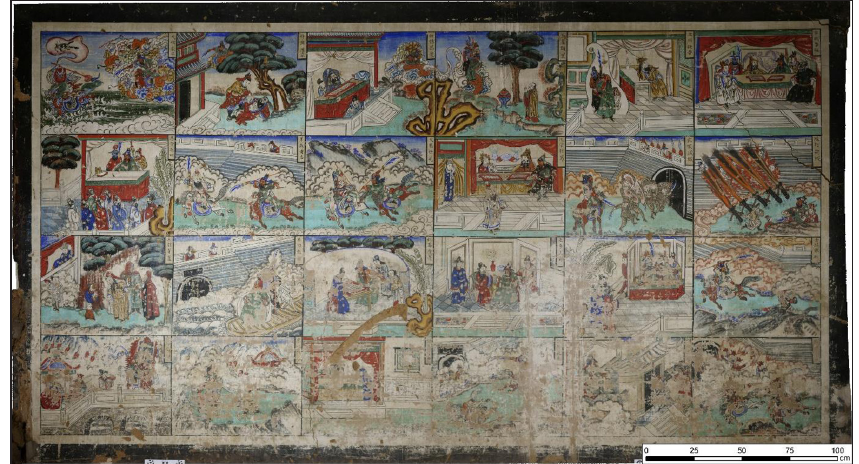
Figure 3: Room1 Wall 1 in Guandi Temple in Shangshahe Village, Daixian County, 代县上沙 河村关帝庙 (SDDP_DXSS004). Image courtesy of the SDDP